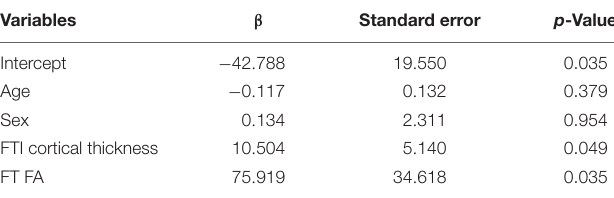
TABLE 2 | General linear model to predict the behavioral score for negative symptoms.